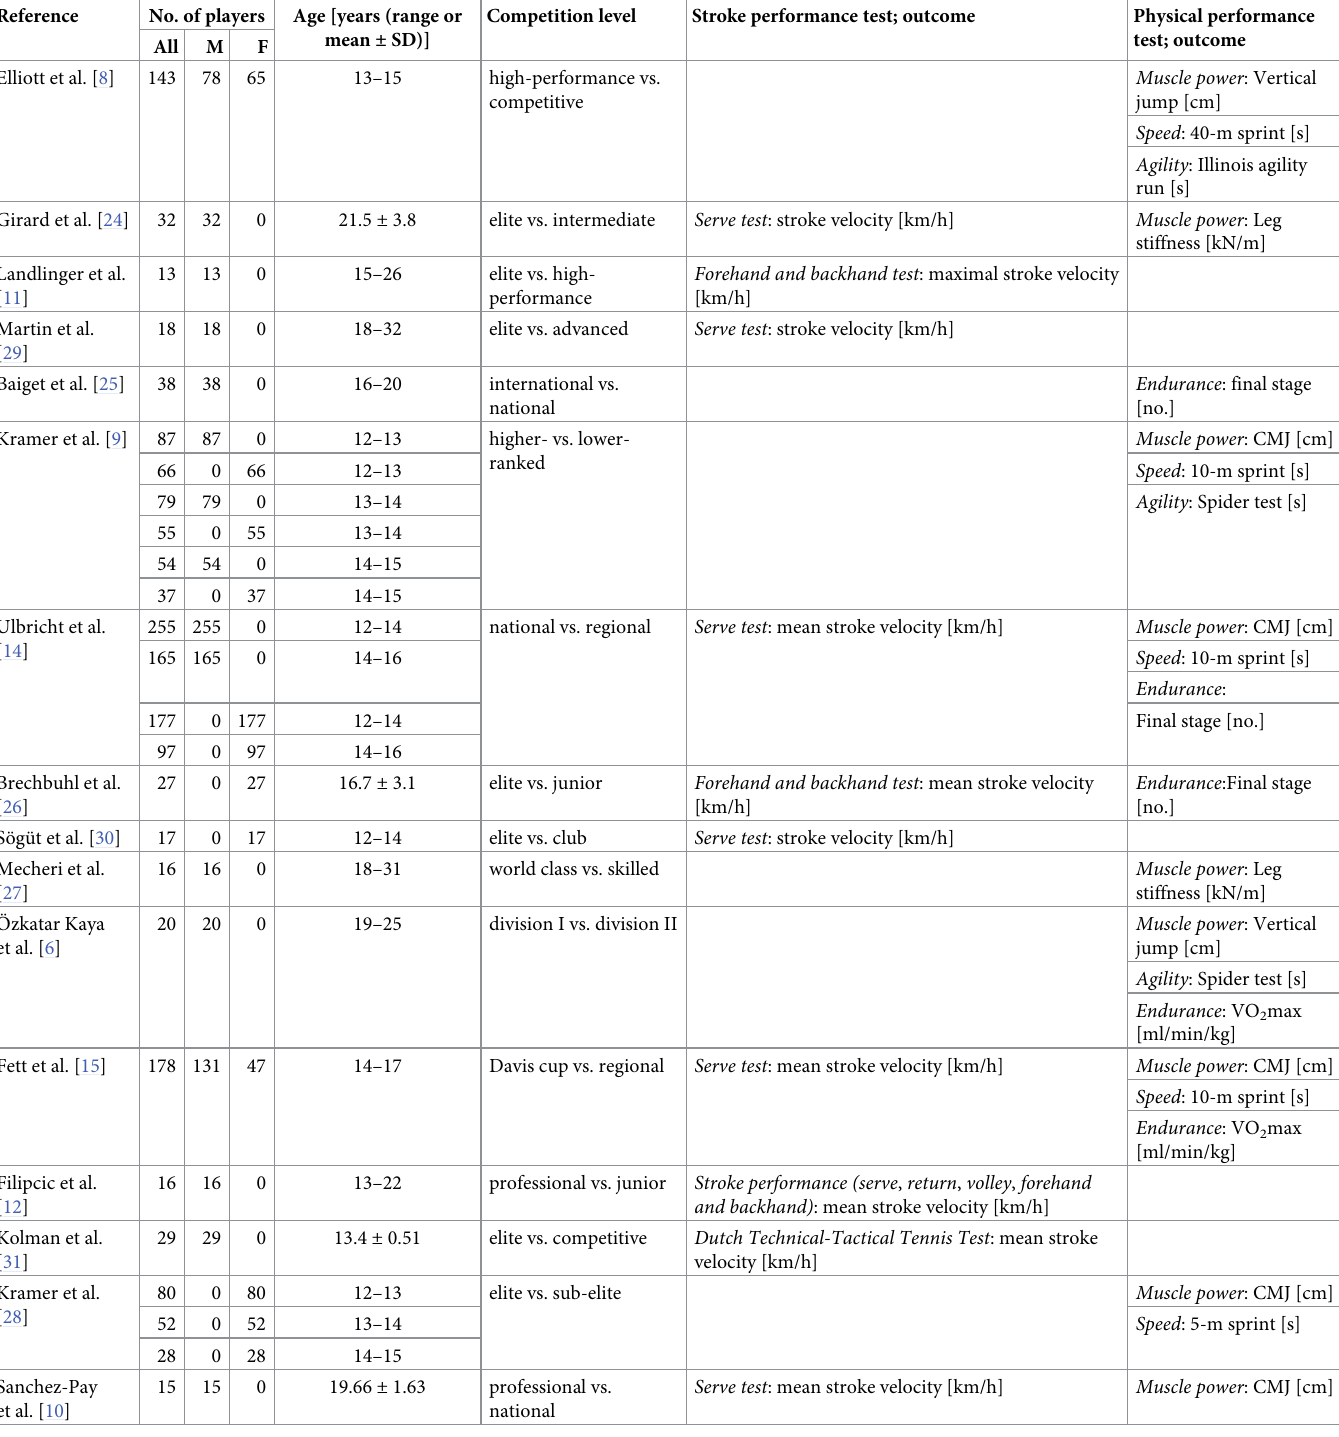
Table 3. Overview of the included studies comparing physical fitness and stroke performance between players with different competition level.